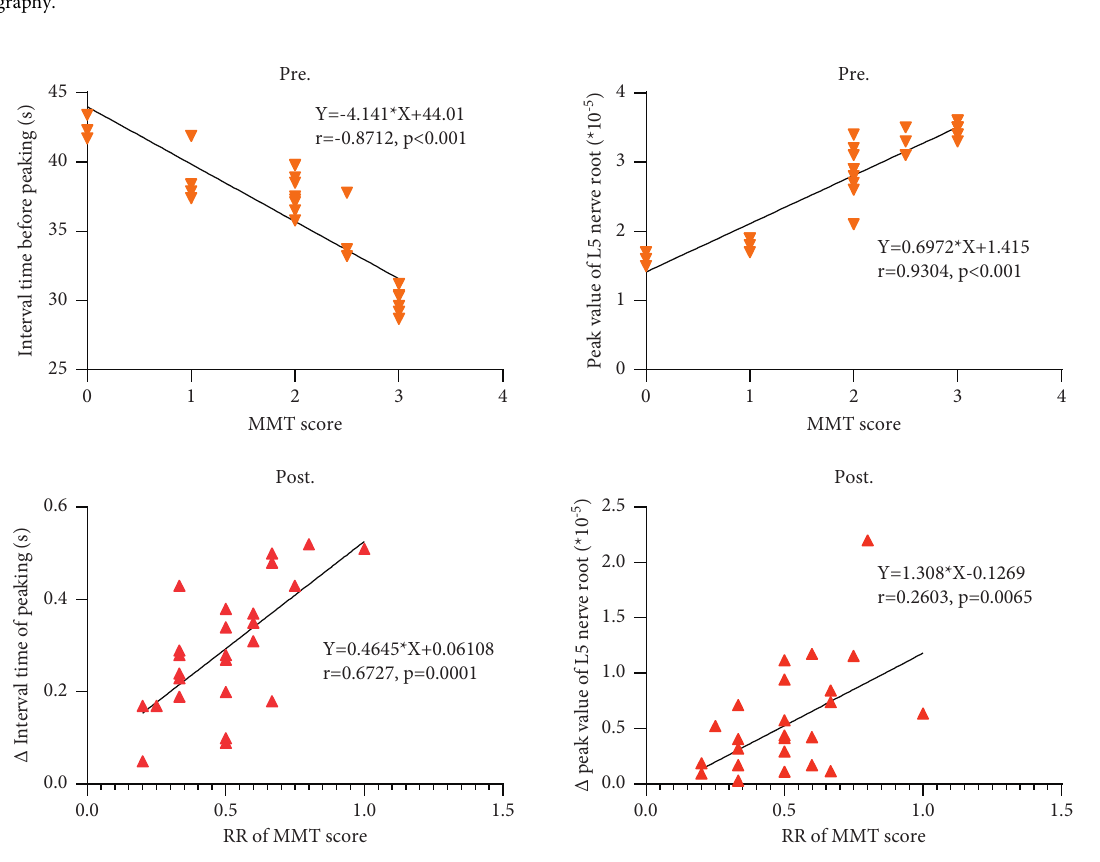
Figure 4: Correlations of the MMT score and IoUS parameters (a) before and (b) after